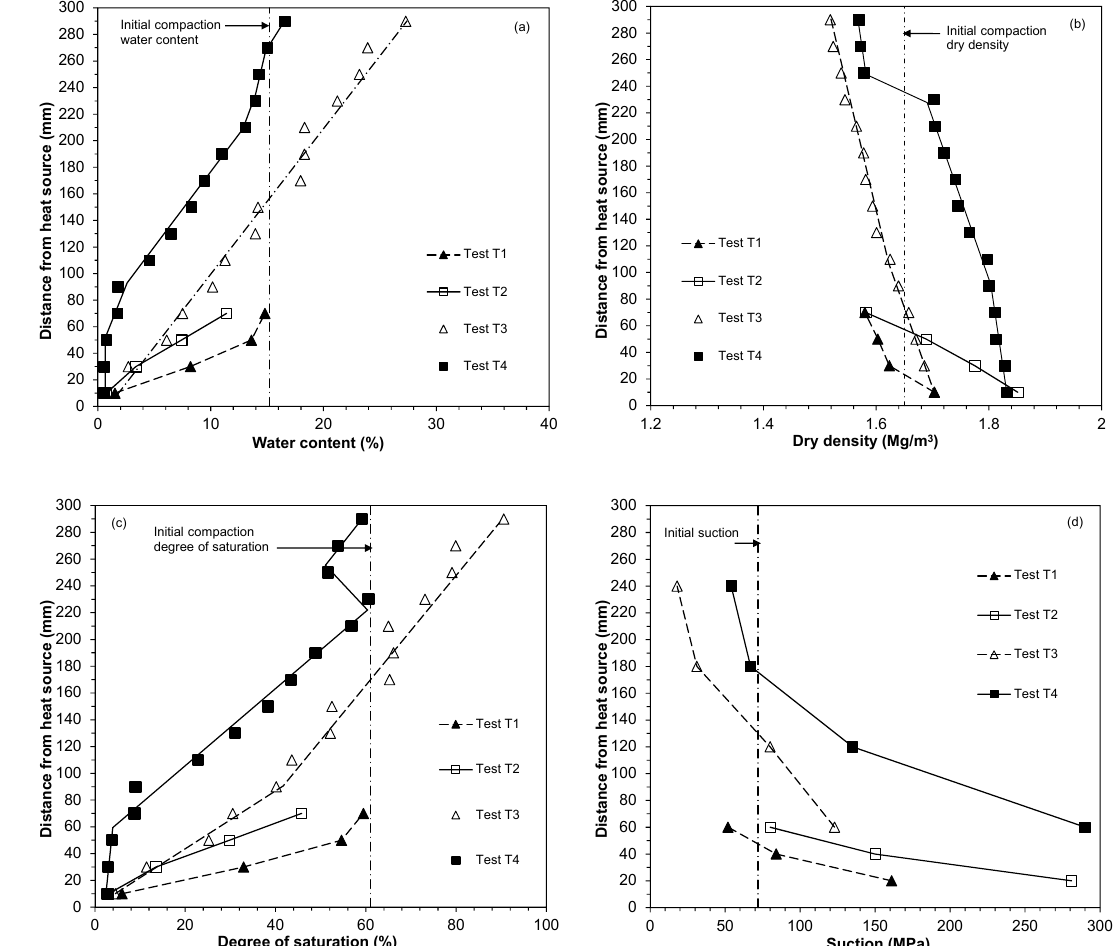
Figure 15. Profiles of: ( a ) water content; ( b ) dry density; ( c ) degree of saturation; ( d ) suction, for non-isothermal tests at 85 °C and 150 °C.